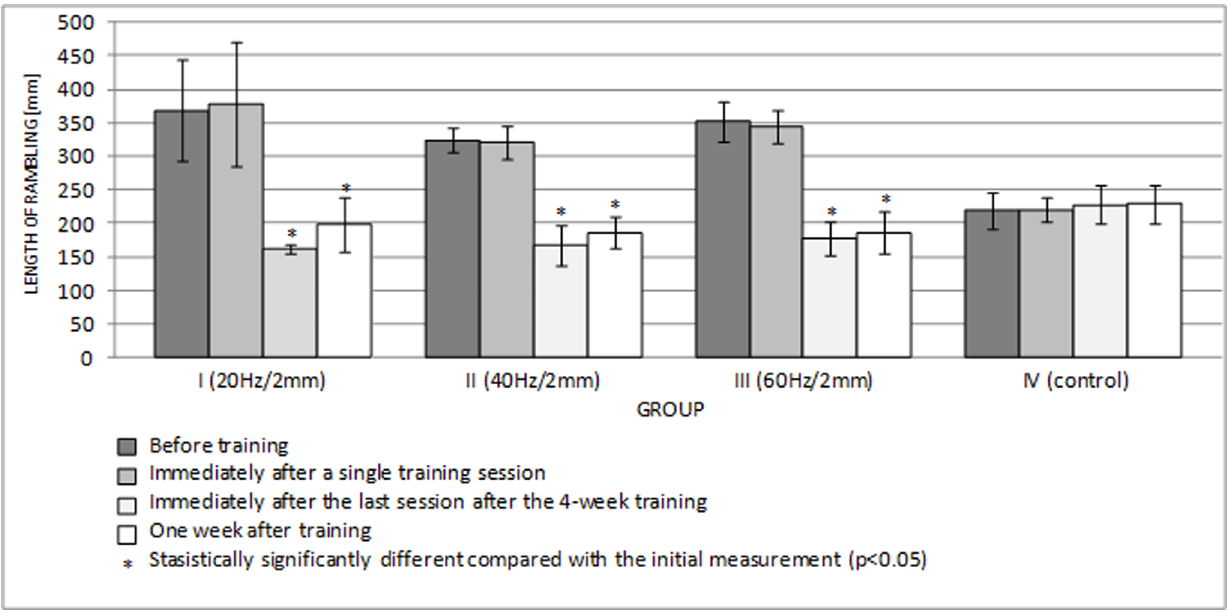
Figure 8. Length of rambling in the ML plane (mean ± standard deviation) (mm) after training.